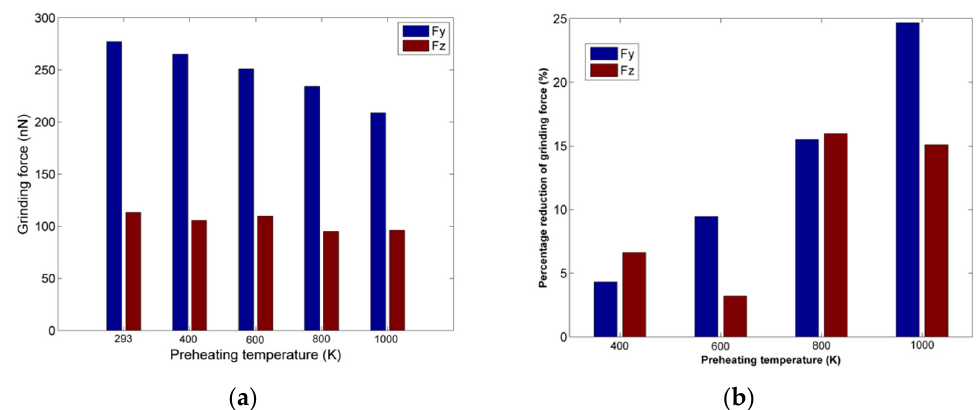
Figure 7. ( a ) Grinding forces values for different preheating temperatures; ( b ) percentage of grinding forces reduction at different preheating temperatures.